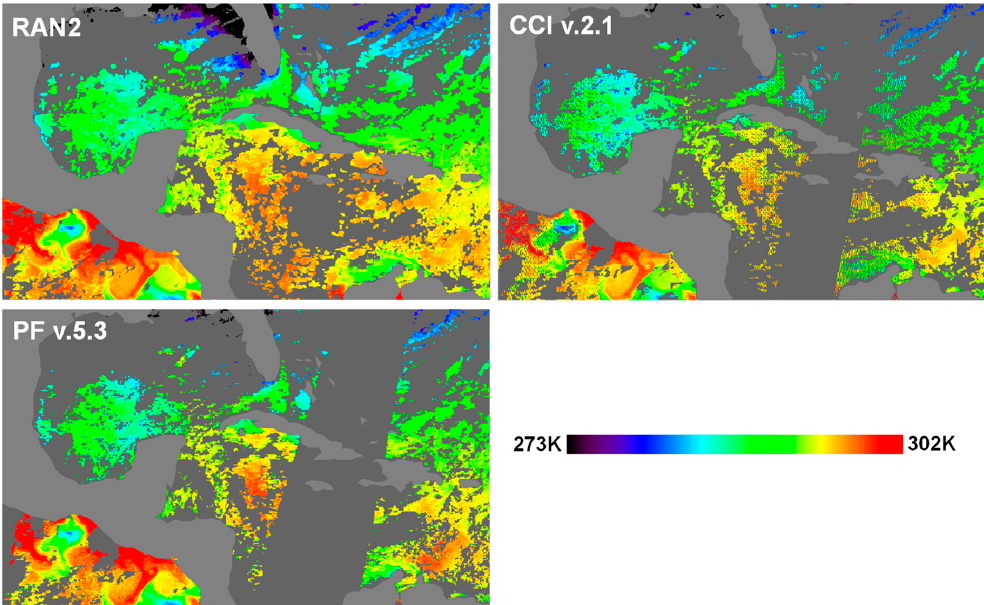
Figure 6. Nighttime N18 L3C ‘subskin’ and ‘skin’ SSTs over the Gulf of Mexico and Caribbean Sea on 1 Jan 2009, produced from RAN2, CCI, and PF L3C. (Note that +0.17 K was added to CCI and PF ‘skin’ SSTs.) Land is rendered in lighter grey and ocean data with missing SST in darker grey.